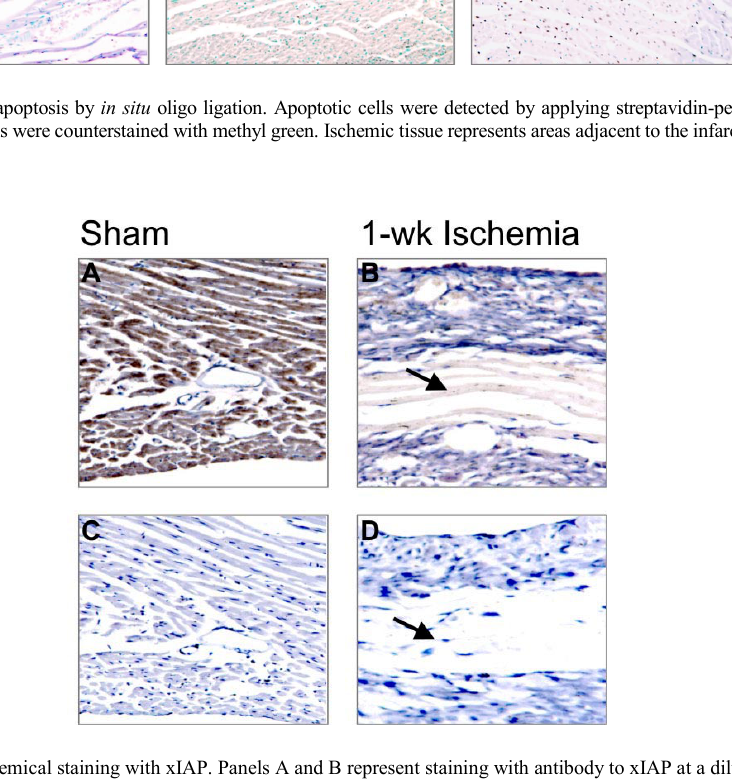
FIGURE 3. Immunohistochemical staining with xIAP. Panels A and B represent staining with antibody to xIAP at a dilution of 1:500. Panels C and D were sections from the same tissues without the addition of primary antibody. Arrow indicates the infarcted region. Magnification,